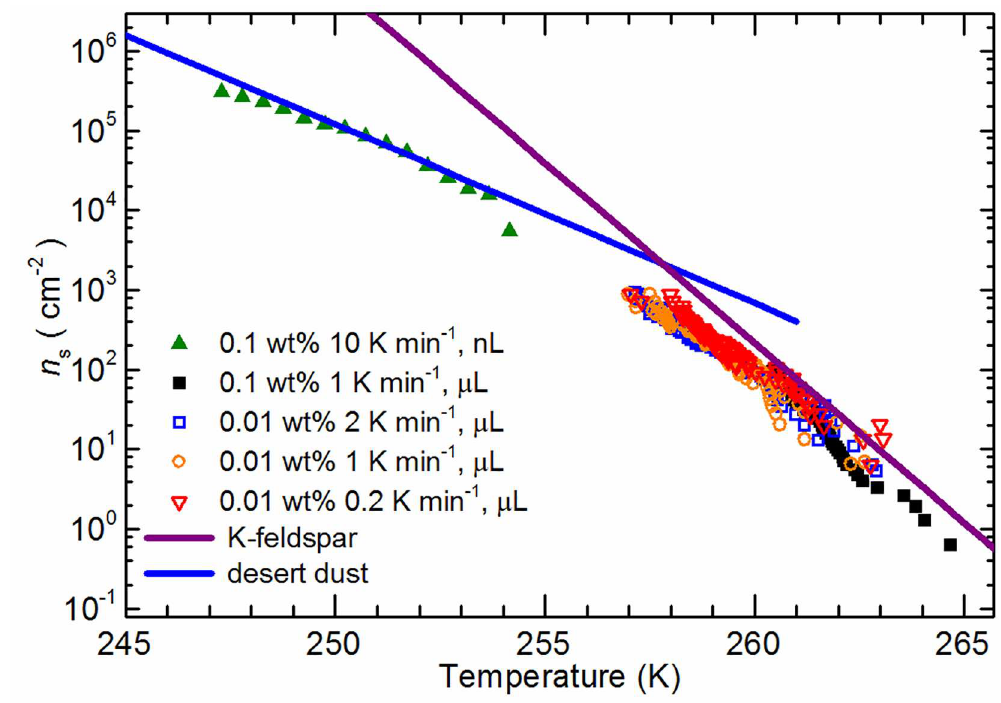
Fig 2. Values of n s in units of cm -2 as a function of temperature, at concentrations of 0.01-0.1 wt%, for droplets of nanolitre and microlitre volume containing Soufriere Hills volcanic ash. Parameterisations of K- feldspar taken from Atkinson et al. [31] and desert dusts taken from Niemand et al. [36] are includedfor